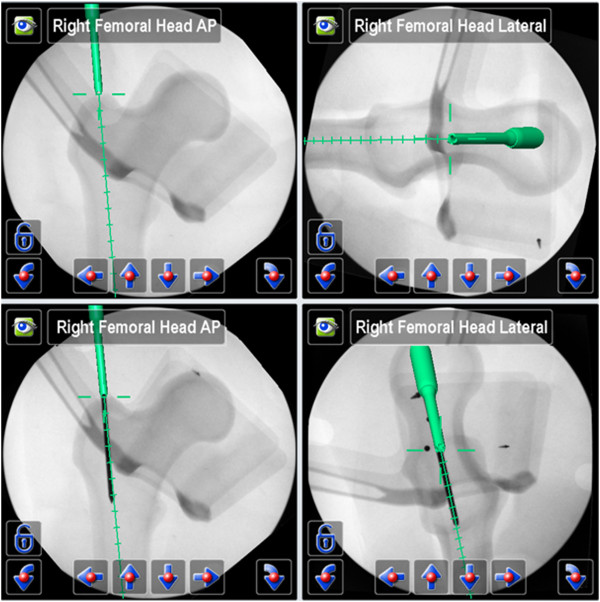
Navigation step 1 → Insertion of guide wire (above), virtual projection with guide wire (below).